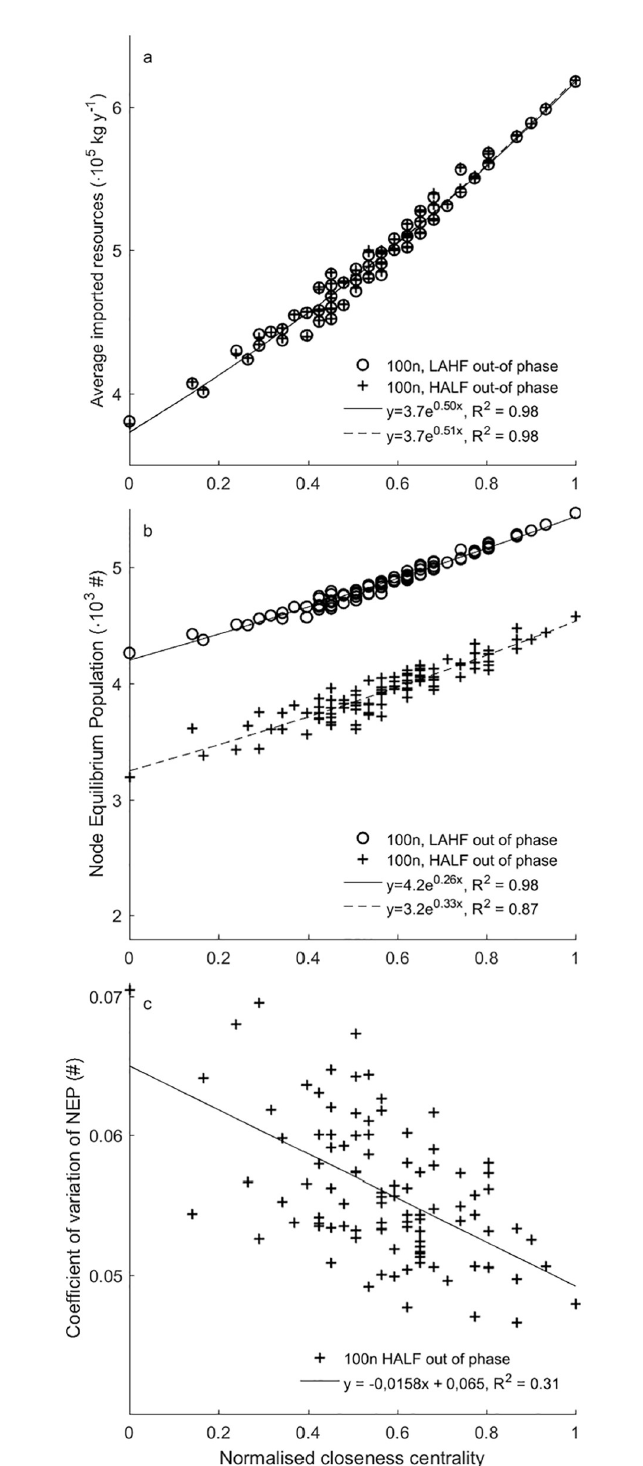
Fig 3. The effect of closeness centrality on Node Equilibrium Population. (A) Average resource import and (B) Node Equilibrium Population (NEP) as a function of the closeness centrality of the 100 node network under two out of phase variability scenarios: low amplitude high frequency (LAHF) and high amplitude low frequency (HALF). (C) The coefficient of variation of NEP as a function of closeness centrality for the high amplitude low frequency scenario